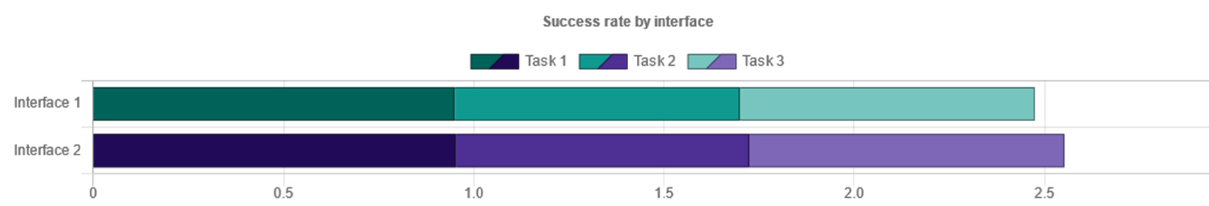
Table 3. Performance metrics and user evaluation for testing interfaces.